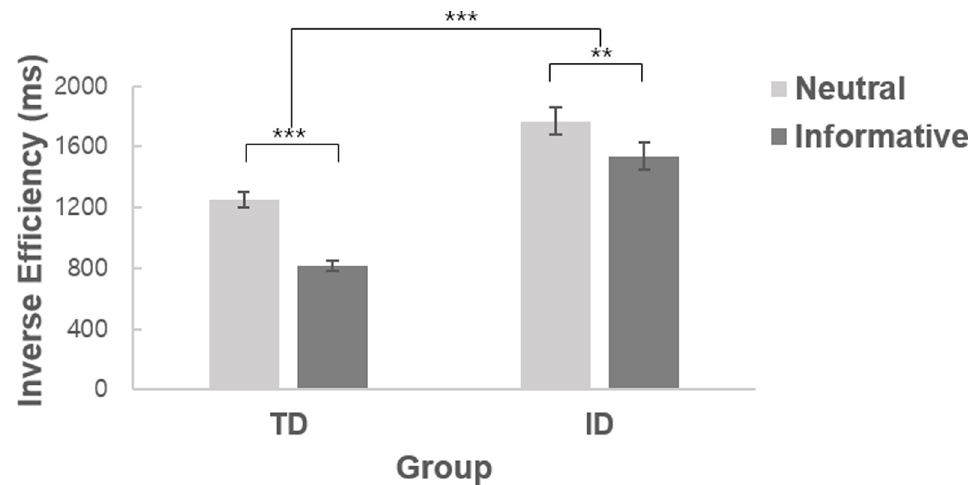
Fig 2. Mean inverse efficiency for neutral versus informative cues, shown separately for the typically developing group (TD) and the intellectual disability group (ID). Error bars represent the SEM in all figures. �� p < .01, ��� p <